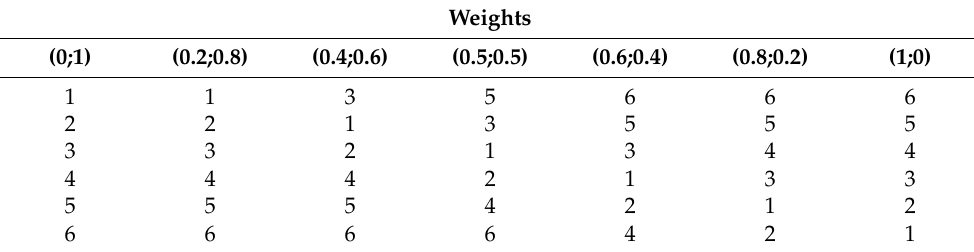
Table 9. Optimum rank corresponding to different weights of the optimization